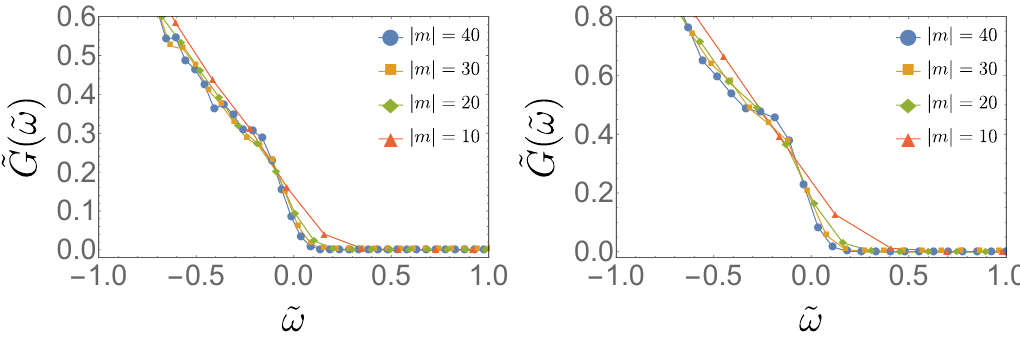
Figure 3: (color online) The power spectra of the Rindler noise, i.e. the Fourier transform of the Wightman function for the interacting Dirac fermions at T = 0 and the pairing function ∆ ≈ 0.25 (left), ∆ ≈ 0.5 (right). We consider here a square lattice on a cylinder (open boundary conditions along x ) of lengths 100 × 100, with the Rindler horizon laying on the circle along y at the half of the cylinder. For each value of the | m | , the ˜ G ( ˜ ω ) are convoluted with a Gaussian filter of 2-site width centered around m . For ∆ ≈ 0.25 (left) the power spectrum is close to one of noninteracting fermions (60), but with an indication of a Fermi-Dirac plateau. The | m | = 40 curve (red) corresponds to the smallest Unruh temperature and therefore we observe an almost step-like sharp response at low energies. Also, the plateau is more evident for ∆ ≈ 0.5 (right), since the number of Cooper pairs becomes significant, see Appendix B. The Fermi-Dirac profile is destroyed close to the horizon. Since the density of Cooper pairs is the greatest near the Dirac points, they dominate lowest energy excitations (close to ˜ ω = 0). For | ˜ ω | (cid:29) 0 the fermionic power spectrum is recovered. Note that the curves were rescaled to account for different proper times of different observers and shifted by ∆ (due to the spectral